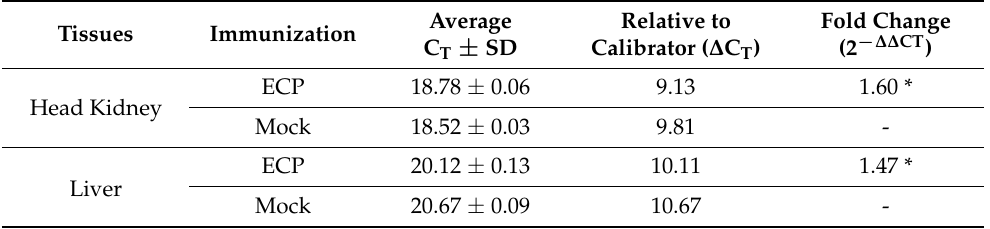
Table 2. Expression of IgM in kidney and liver tissues between ECP-immunized and mock- immunized channel